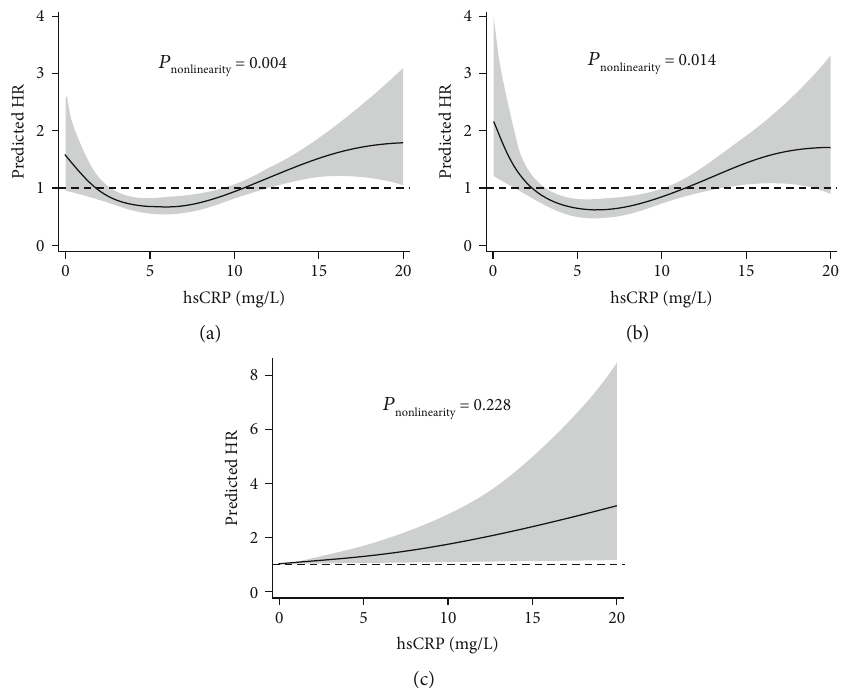
Figure 1: Continuous hazard ratio across hsCRP for all-cause death (a), cardiac death (b), and noncardiac death (c). HR: hazard ratio; hsCRP: high-sensitivity C-reactive